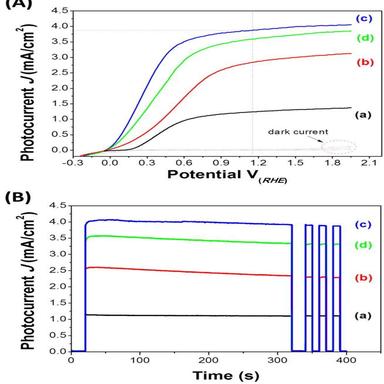
(A) J–V curve and (B) photocurrent stability and transient photocurrent response to on-off cycles for (a) bare TONR/FTO, (b) (×3)-CdIS/TONR/FTO, (c) (×4)-CdIS/TONR/FTO, and (d) (×5)-CdIS/TONR/FTOphotoanodes under 1 sun light illumination, (Na2S+ Na2SO3) mixed sulfide electrolyte at scan rate 50 mV s−1 .